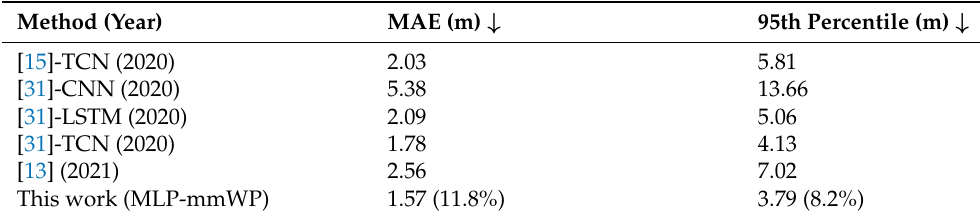
Table 3. Results of comparisons with other state-of-the-art methods. The best performance is labeled in boldface, and the suboptimal performance is